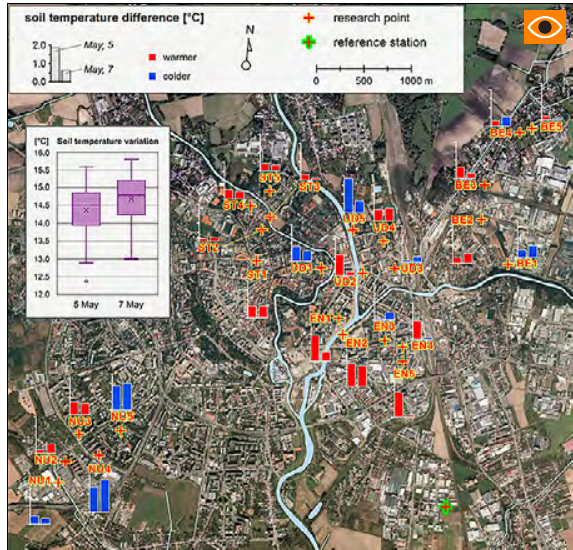
Figure 3. Soil temperature in 20-cm depth at research points of the field experiment in Olomouc, 5 and 7 May